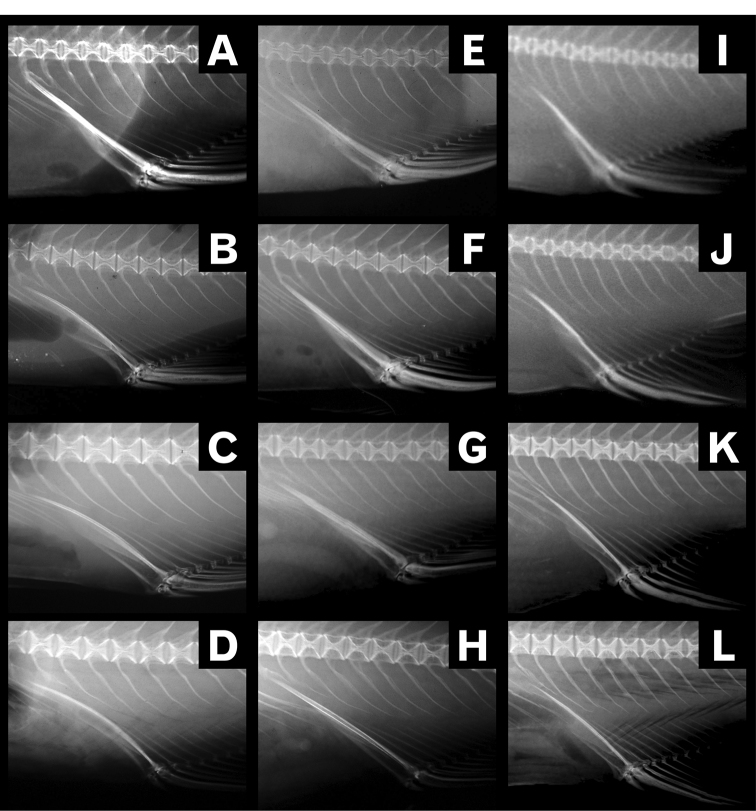
Radiographs of first anal pterygiophores in Lateolabraxjaponicus (A–D), L.maculatus (E–H) and L.latus (I–L), according to body size by species. AKAUM–I. 82683 (65.6 mm SL) BBSKU 100883 (96.8 mm SL) CBSKU 100756 (252.4 mm SL) DKPM-NI 9697 (317.0 mm SL) E uncatalogued specimen (58.4 mm SL) FTKPM-P 1655-6 (95.2 mm SL) GBSKU 100771 (250.8 mm SL) HKPM-NI 9686 (364.0 mm SL) IKAUM–I. 1895-4 (70.3 mm SL) JKAUM–I. 64737 (SL 94.2 mm) KKPM-NI 24650 (265.4 mm SL) LKAUM–I. 57963 (342.0 mm SL).